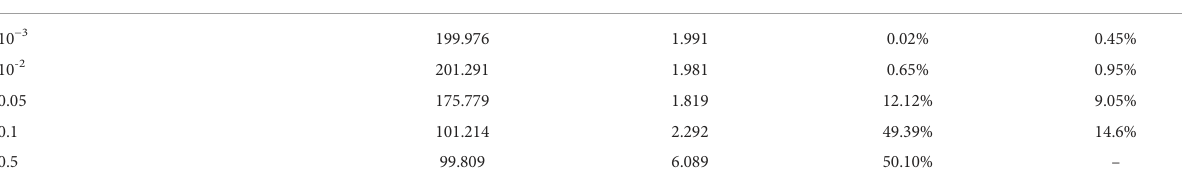
TABLE 5 Dependence of the optimally estimated on the standard deviation of the temperature observation. Std dev of temperature observation Estimated value of a Estimated value of b Relative error of a Relative error of